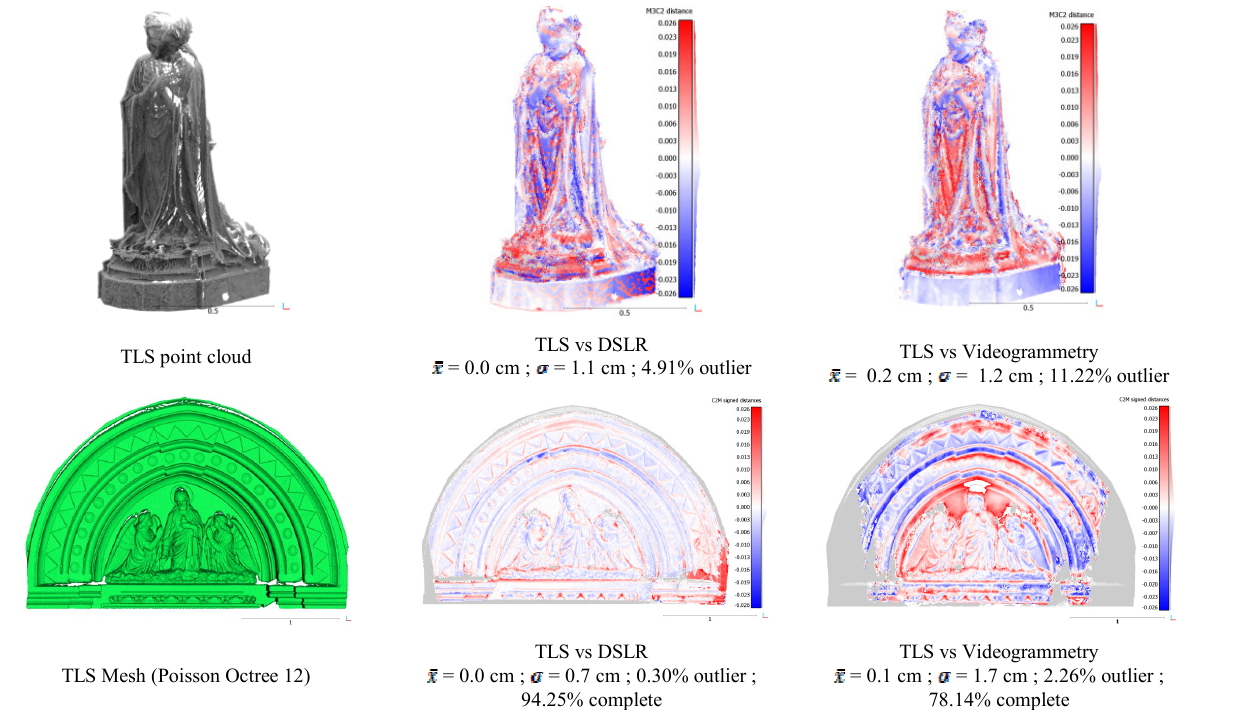
Figure 3. Geometric analysis for the data from Figure 2 (d) and (f). denotes average deviation from TLS and the standard deviation. The outlier points are points with a deviation greater than the set tolerance. The completeness level is how close each respective point cloud covers the ideal closed surface as represented by the TLS mesh.